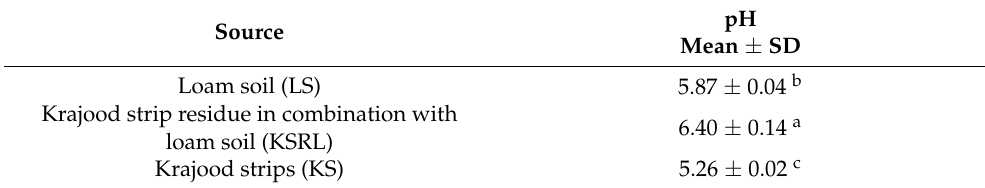
Table 4. The pH of Krajood strips, and KSRL and loam soil.